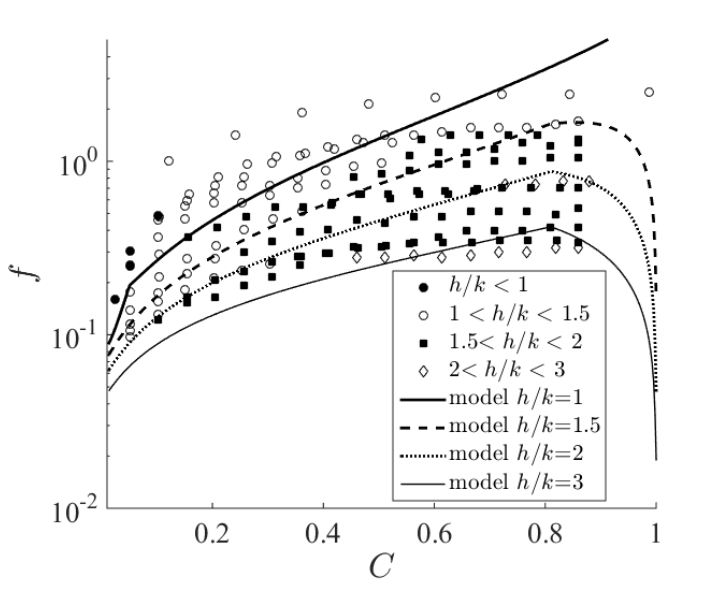
Figure 6. Friction coefficients from [18] for randomly spatialized obstacles as a function of the concentration, in comparison to the present model results ( h / k = 1.1, 1.5, 2,